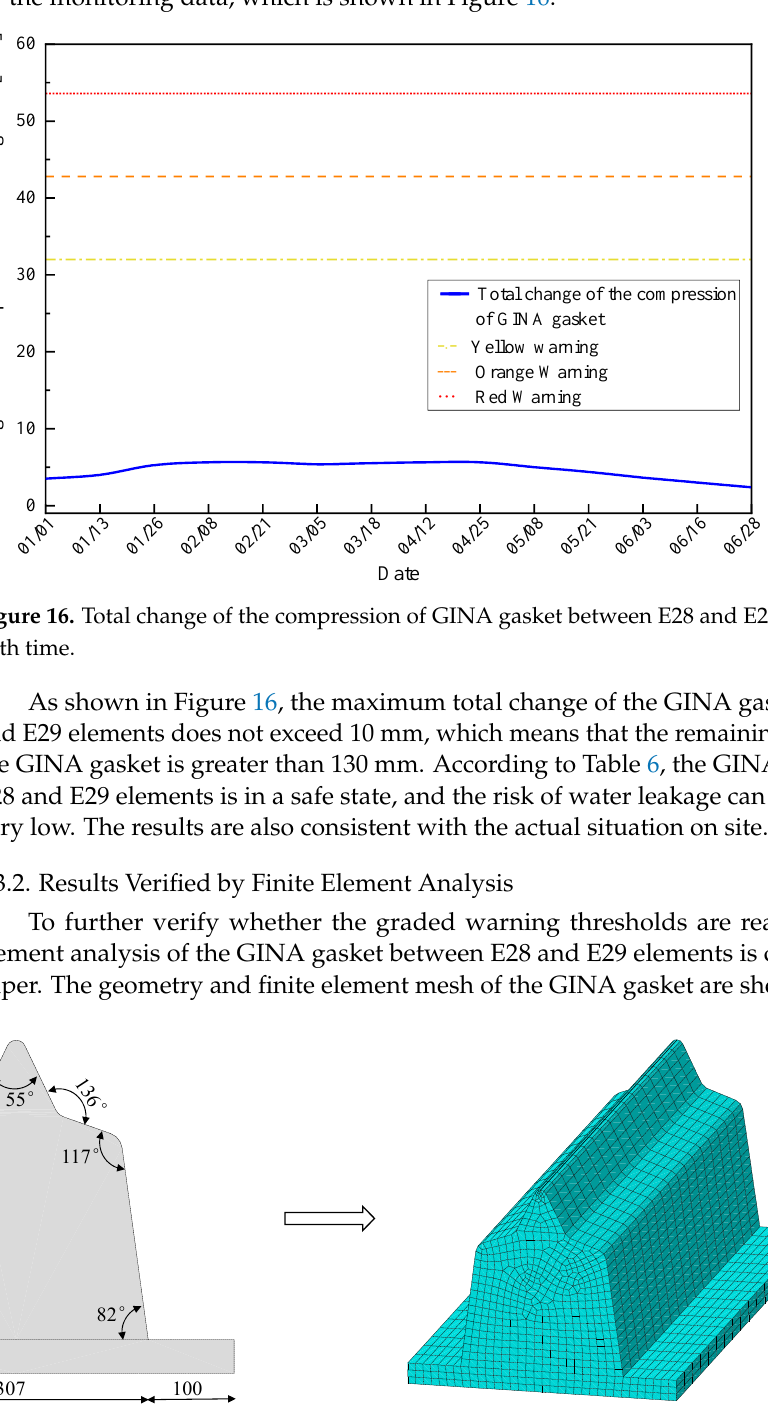
Figure 15. Mechanical decomposition of the deformation modes of immersed tunnel joint between E28 and E29 elements.